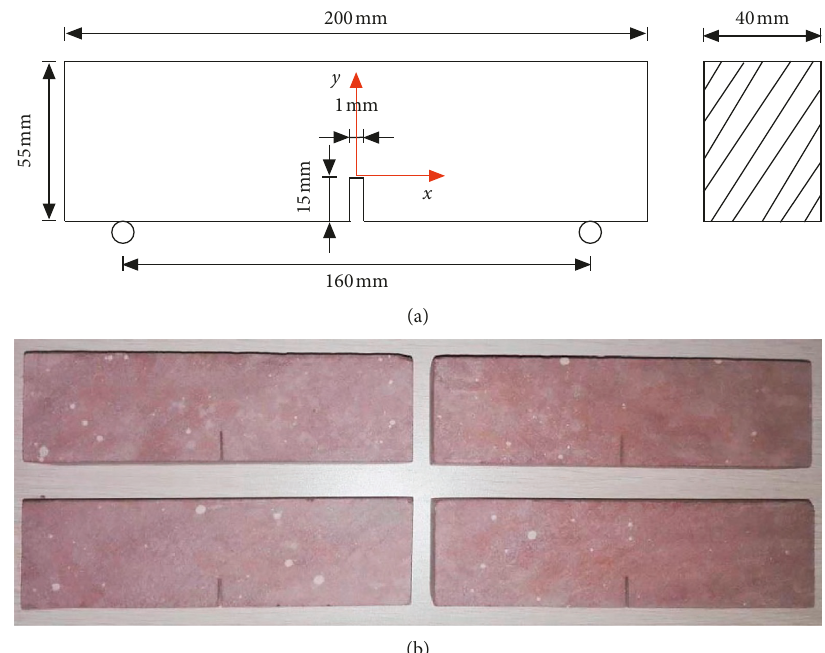
Figure 1: Preparation of the sandstone specimens for the TPB experiments: (a) schematic of the specimen and (b) the tested sandstone